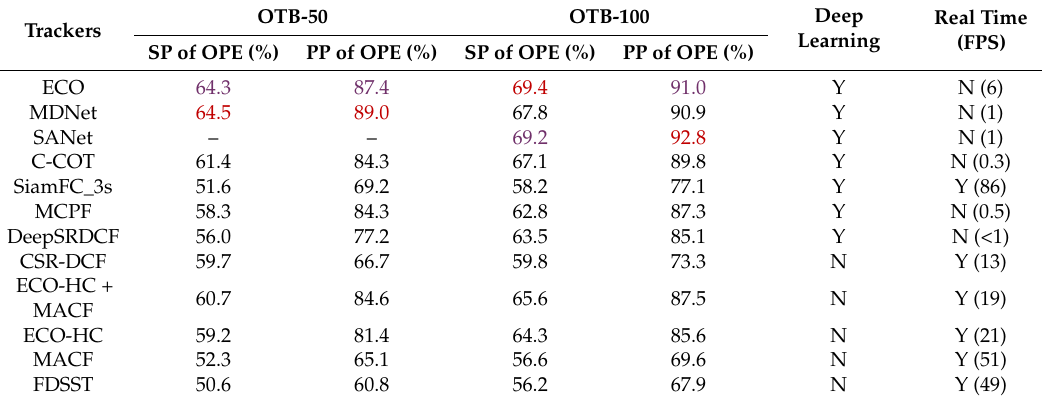
Table 6. SP and PP of OPE for the proposed MACF, ECO-HC + MACF and the other 10 top trackers on the raw benchmark results of OTB-50 and OTB-100. The last column is the performance of Real-Time and the results are from the original paper, not tested on the same platform. The column of Deep Learning indicates whether the tracker is based on deep learning features. The best results are in red and the second results are in